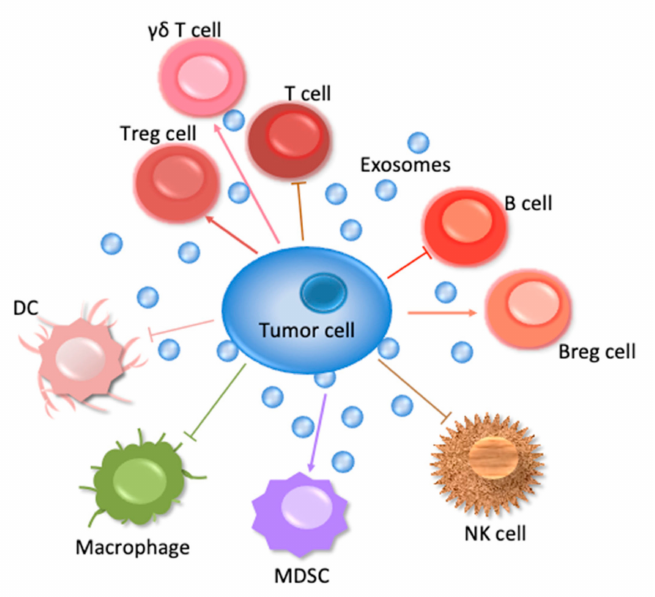
Figure 1. Interactions of immune cells with a tumor cell. Lymphoid cells comprise T, B, NK cells, and myeloid cells comprise DC, macrophages.